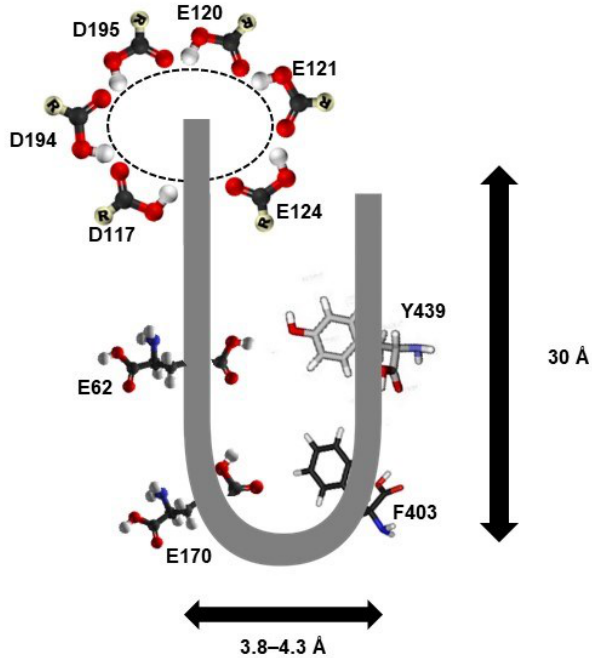
Figure 3. Diagrammatic representation of the active site of maize PAO. The PAO active site is represented by a characteristic U-shaped tunnel having a dimension of 30 × 3.8–4.3 Å. The side walls of the tunnel are lined by catalytic residues F403 and Y439, which make an aromatic sandwich. The base of the tunnel has E62 and E170. The mouth of the tunnel has an electron cloud created by E120, E121, E124, D117, D194, and D195. The solid lines represent the shape of the catalytic site. Red cir- cle — oxygen, white — hydrogen, black — carbon, dashed circular line — electron cloud.